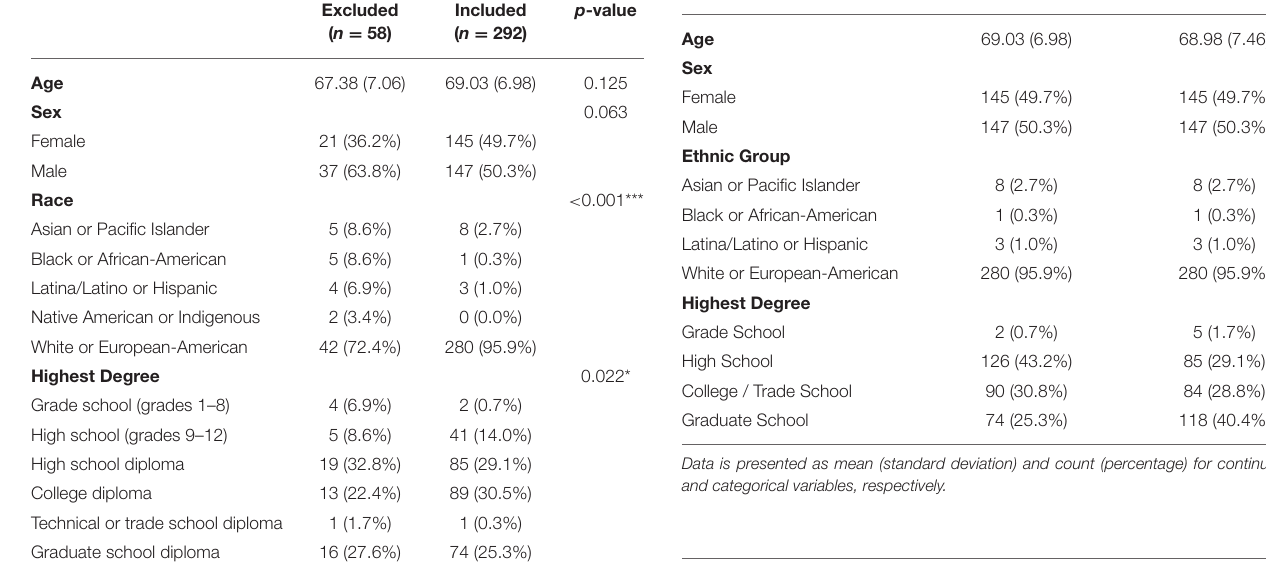
TABLE 4 | Genetic factors associated with PSP